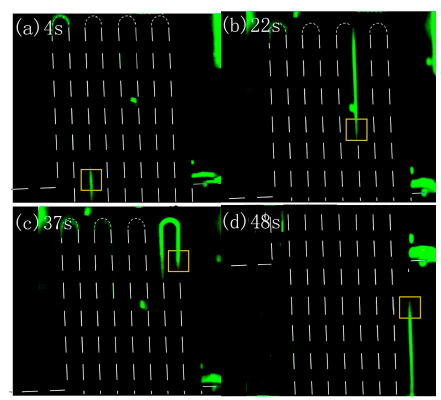
Figure 16. Fluorescence microscopy images of the derivatized amino acids positions at different times with a voltage of 620 V applied across the migration channel and 200 V across the sampling channel. ( a ) 4 s; ( b ) 22 s; ( c ) 37 s; ( d ) 48 s.